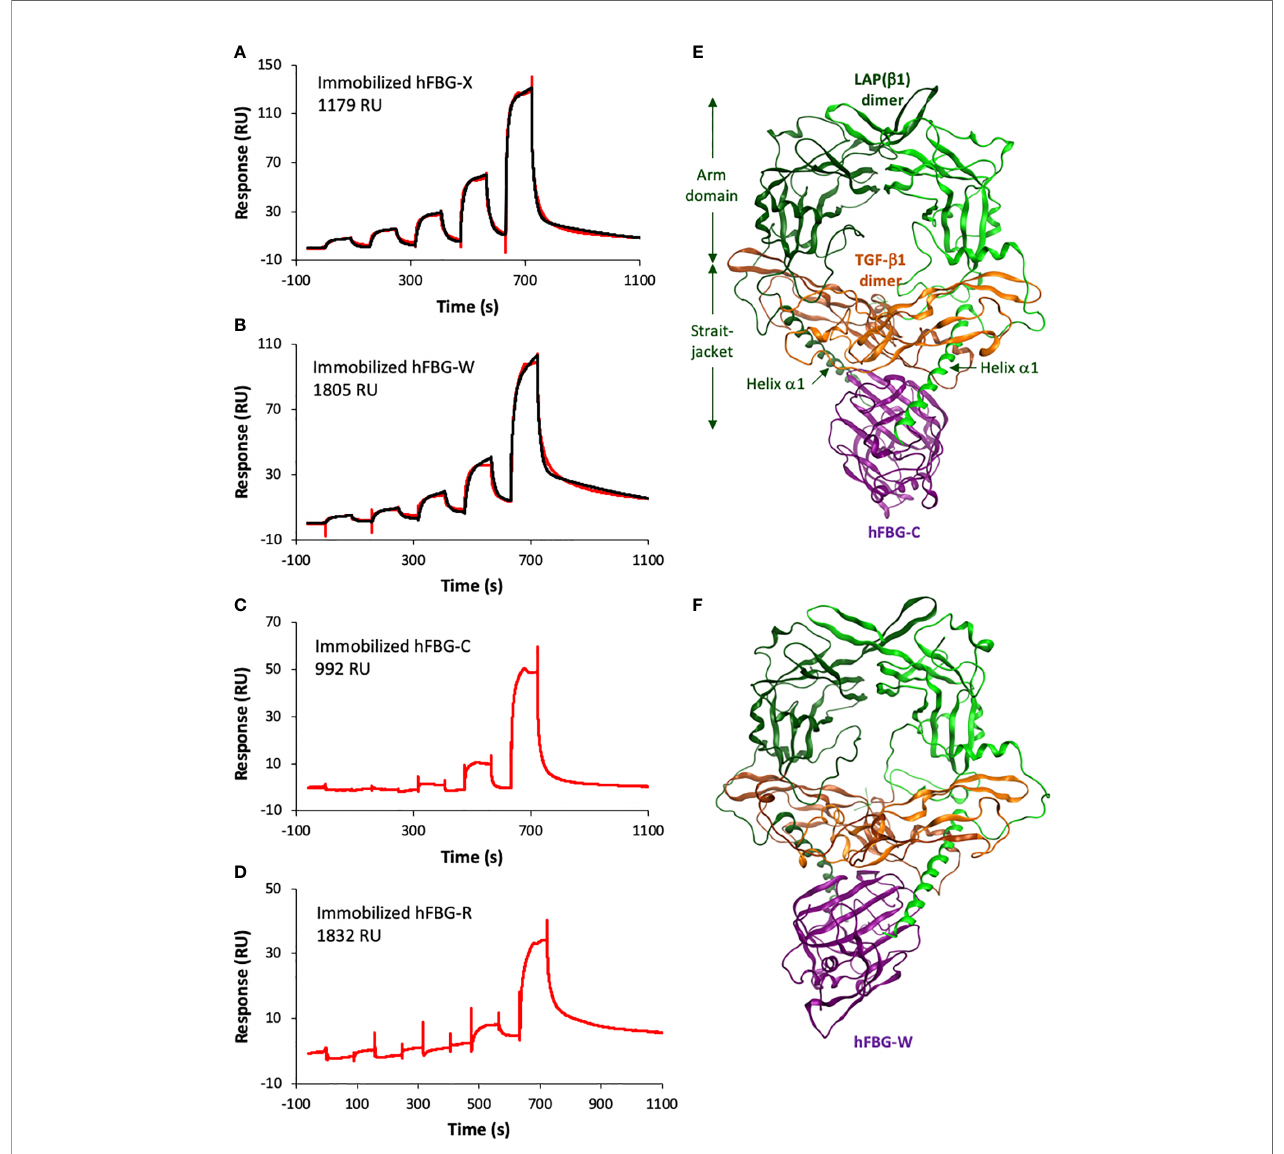
FIGURE 3 | The recombinant FBG-like domains of Tenascins interact with TGF- b 1. (A – D) Interactions of TGF- b 1 with FBG-like domains analyzed by SPR. Increasing concentrations of TGF- b 1 were injected in single-cycle mode over immobilized FBG-X (A) , FBG-W (B) , FBG-C (C) and FBG-R (D) . The experimental curves are shown in red and the best fi ts with the heterogeneous ligand model in black. The concentrations of TGF- b 1 were as follows: (A) 15.6 – 31.2 – 62.5 – 125 – 250 nM; (B) 7.8 – 15.6 – 31.25 – 62.5 – 125 nM; (C) 20.2 – 40.5 – 81 – 162 – 324 nM; (D) 9.4 – 18.8 – 37.5 – 75 – 150 nM. (E, F) Homology models showing the predicted docking between the FBG-like domain of TN-C (E) or TN-W (F) and the pro-TGF- b 1. The dimeric LAP( b 1) pro-domain is shown in green, the TGF- b 1 dimer in orange and the FBG-like domains in purple. ‘ Straitjacket ’ and arm domains of the LAP( b 1) dimer are indicated.